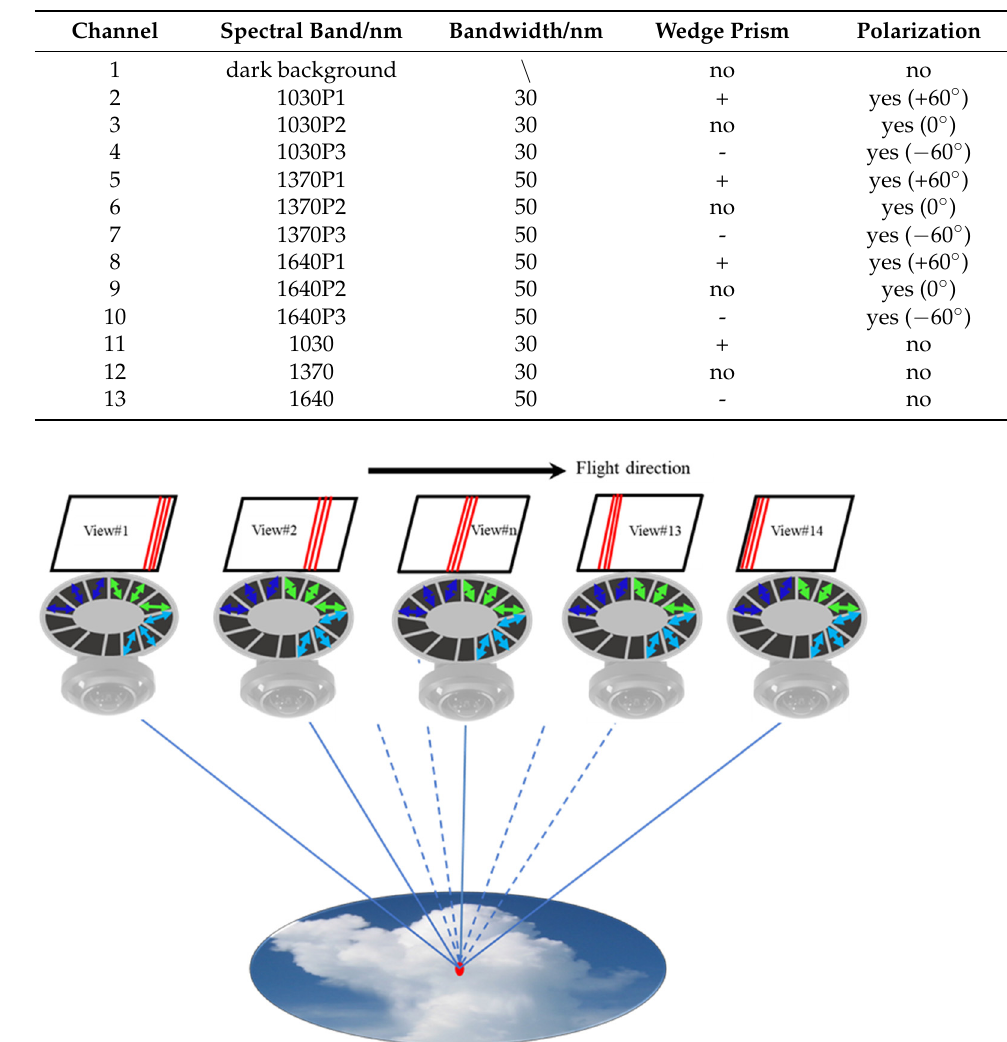
Table 3. Characteristics of the 6 designed MAPI bands.